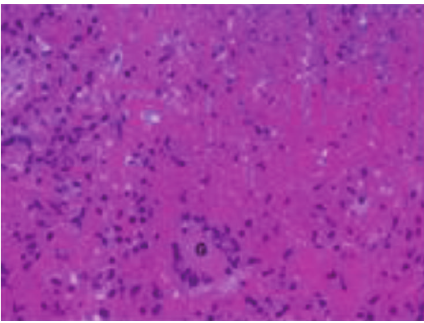
Figure 3: Scattered multinucleated giant cells (G) (H&E stain, 50x magnification).